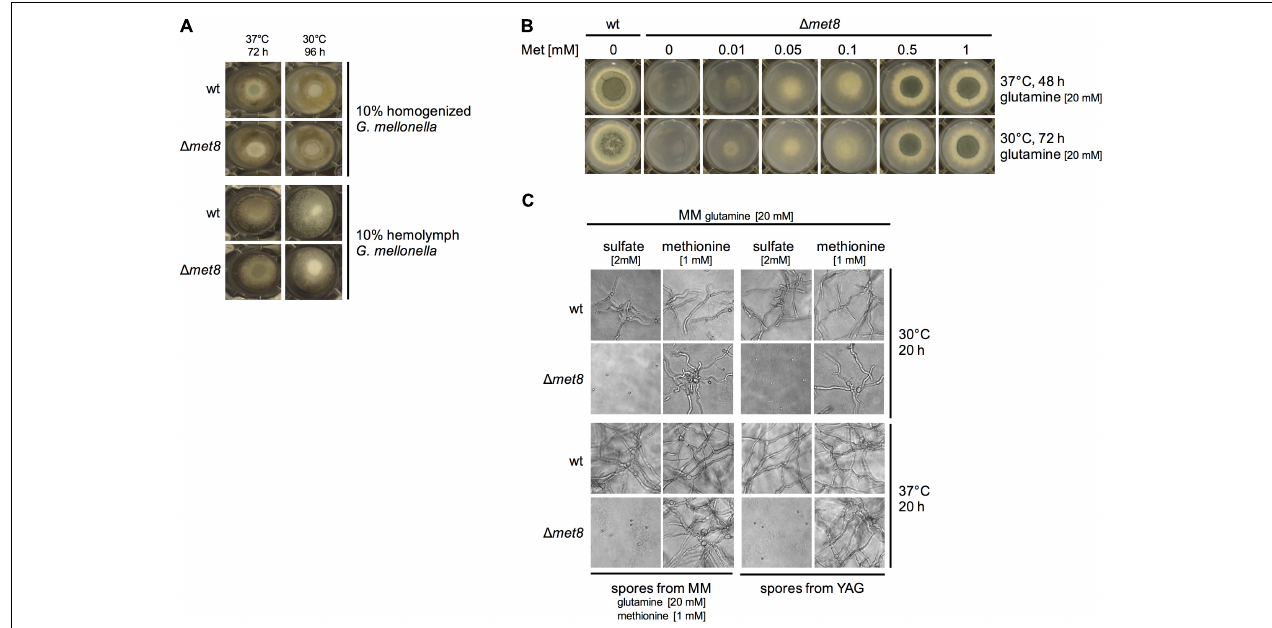
FIGURE 6 | Lack of Met8 does not affect growth on G. mellonella extracts and hemolymph (A) , does not impact growth at 30 ◦ C compared to 37 ◦ C (B) , and blocks germination in minimal medium lacking an organic sulfur source (C) . (A,B) 10 4 spores of the respective fungal strain were point-inoculated on the indicated growth medium and photographs were taken after the indicated incubation period and temperature. (C) To analyze germination and growth, 10 5 conidia/ml were inoculated in liquid minimal medium containing glutamine as nitrogen source and either sulfate or methionine as sulfur source; photographs were taken after the indicated incubation period and